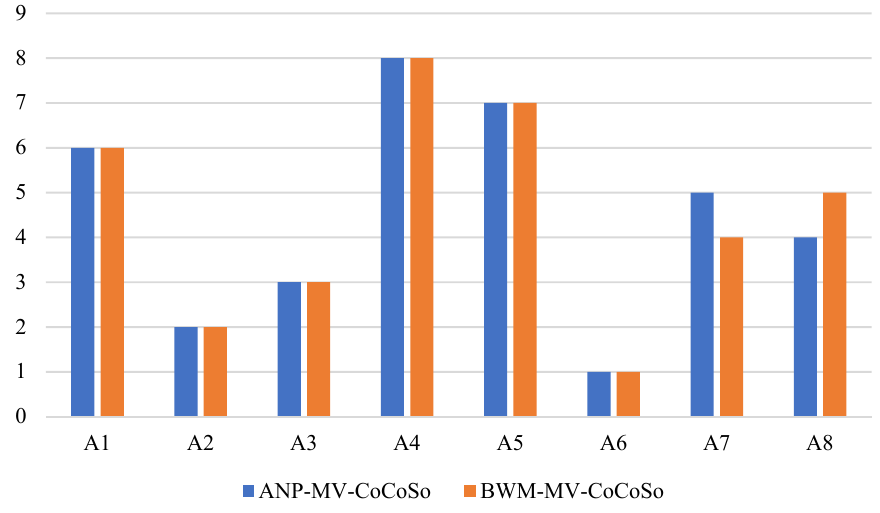
Figure 3. ANP–MV–CoCoSo and BWM–MV–CoCoSo results.